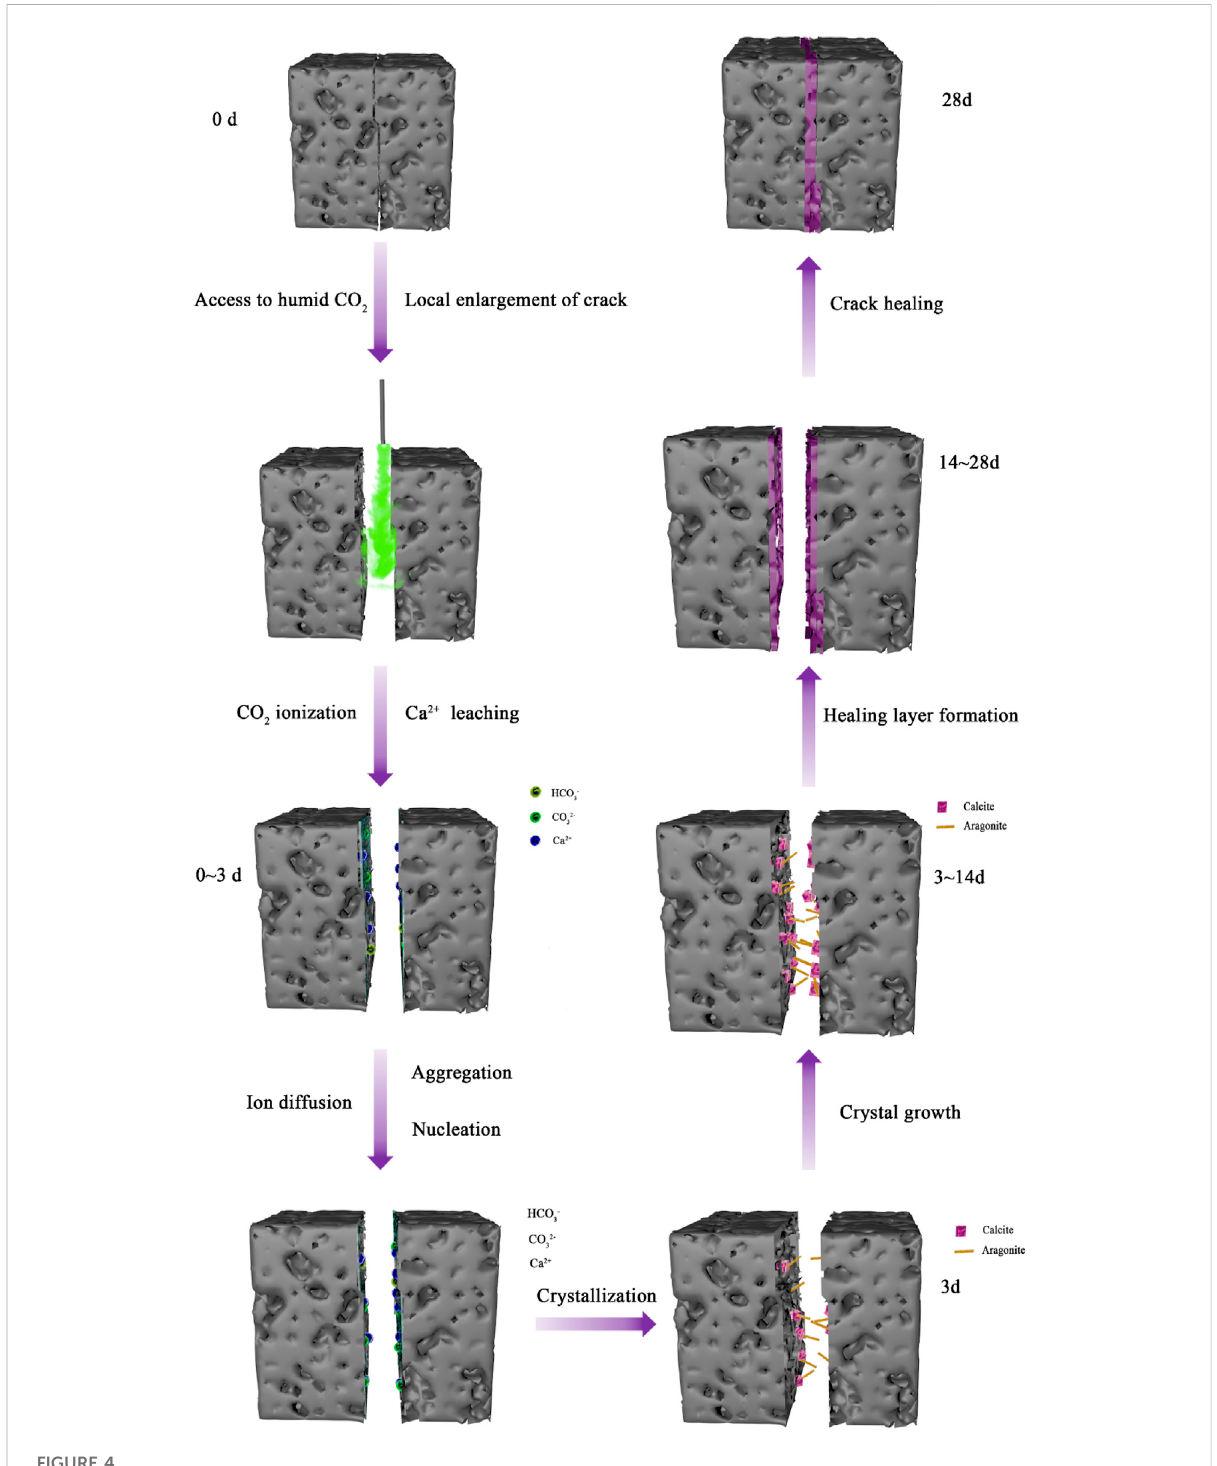
FIGURE 4 Self-healing mechanism of CO 2 -induced CaCO 3